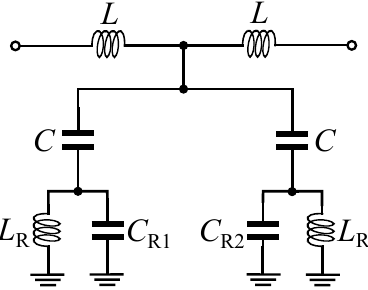
Figure 5. Equivalent circuit model of the sensor in Figure 4.